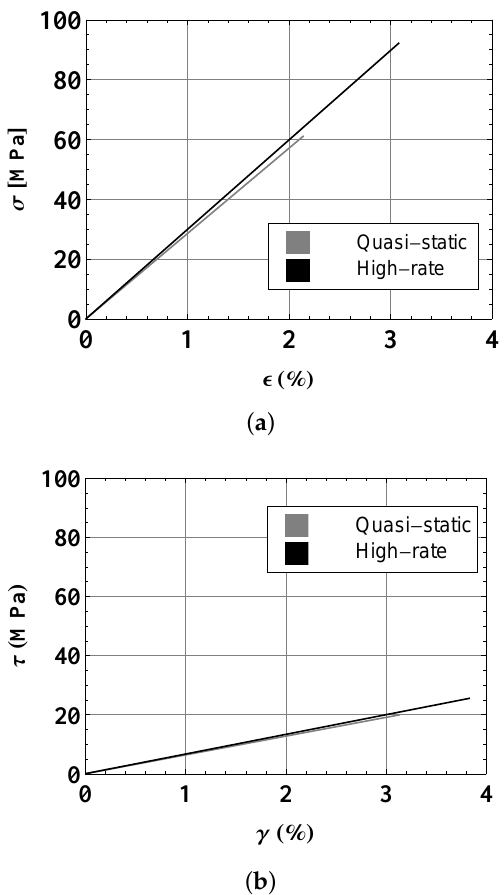
Figure 3. Stress–strain curves in combined tensile–torsion loading conditions: ( a ) Tensile stress– strain curves of the adhesive layer obtained with the proposed model for quasi-static and high-rate loading. ( b ) Torsion stress–strain curves of the adhesive layer obtained with the proposed model for quasi-static and high-rate